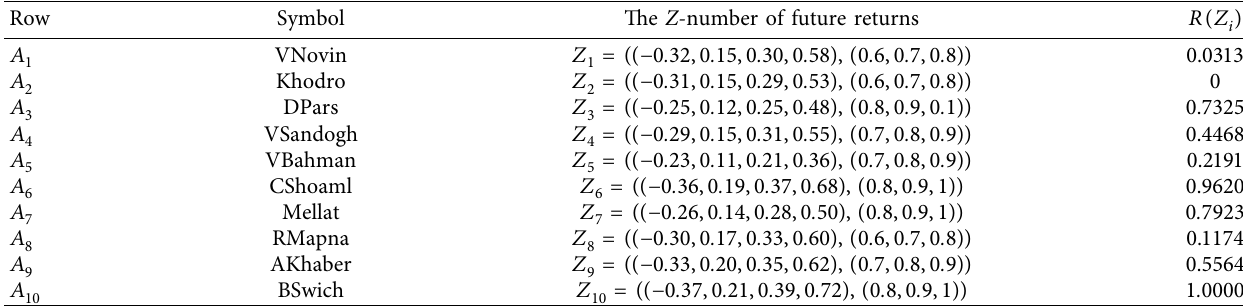
Table 4: Te rank of assets.